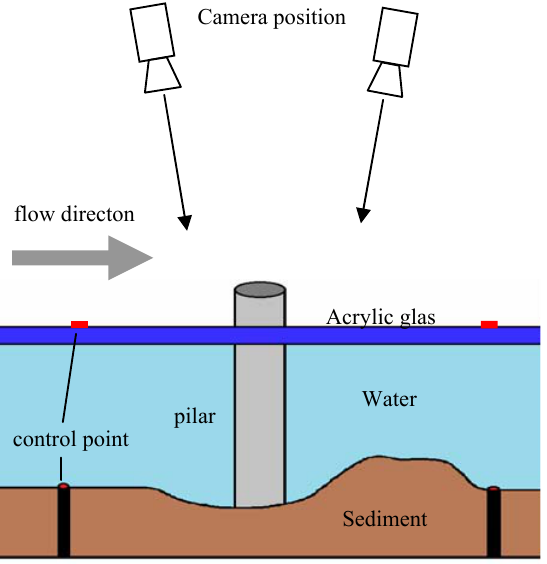
Figure 2. Schematic sketch of the experimental set up Two digital cameras with a focal length of 24 mm were mounted approximately 2.5 meter above the channel. The used cameras are components of a Particle Image Velocimetry (PIV)